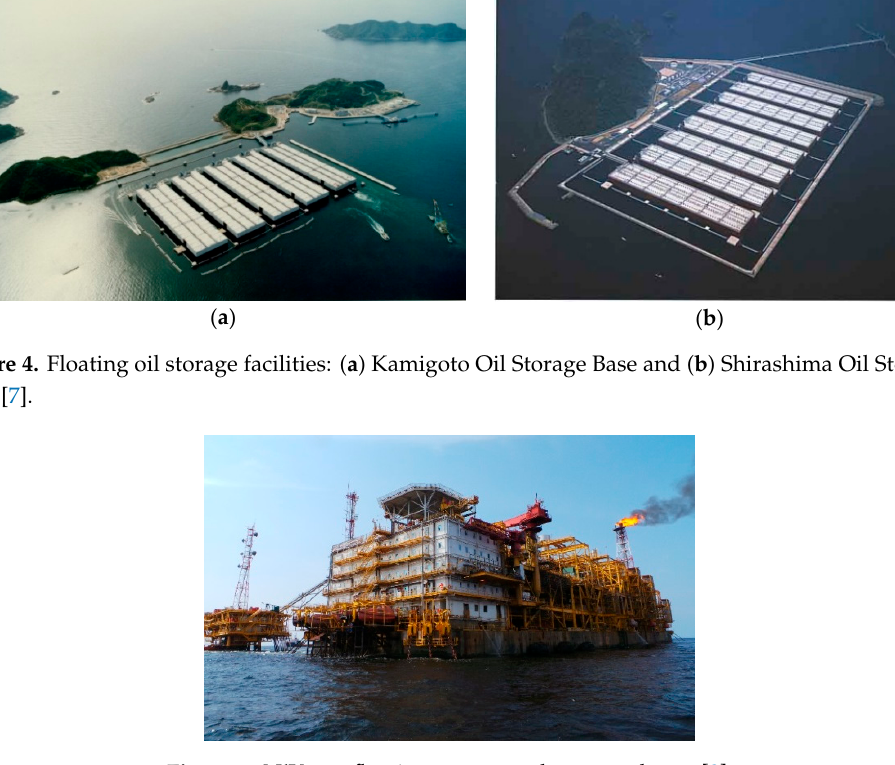
Figure 5. N’Kossa floating prestressed concrete barge [8].